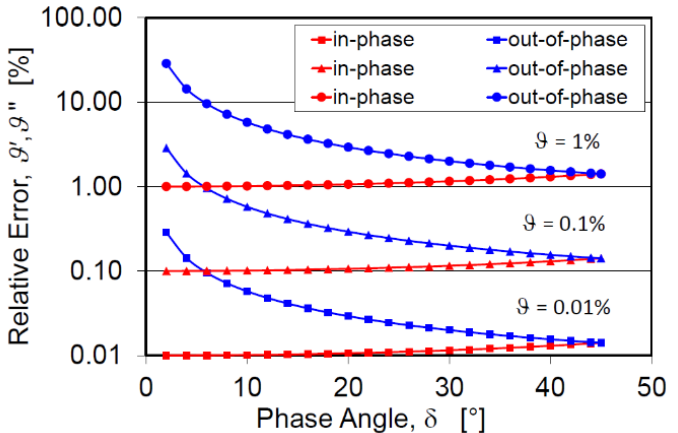
Figure 3. Relative errors in ipMS ( ϑ (cid:48) , red symbols) and opMS ( ϑ (cid:48)(cid:48) , blue symbols) according to the rock phase angle ( δ ) and relative error in measuring directional susceptibility ϑ . Adapted from Hrouda et al.